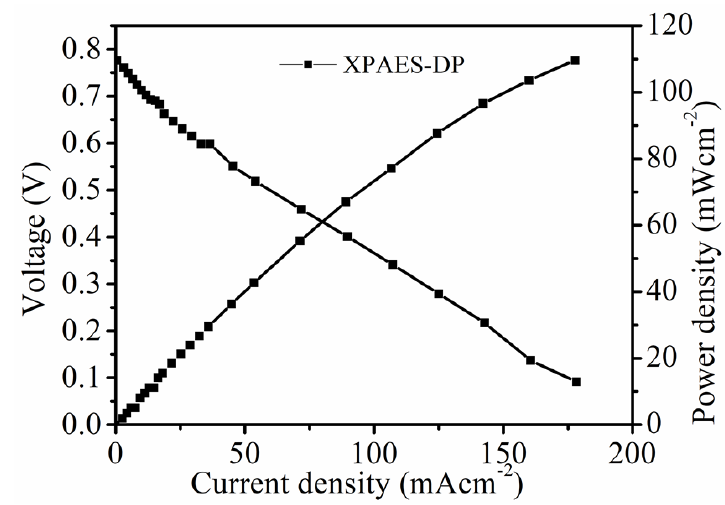
Figure 6. Polarization curve of XPAES-DP at 80 °C and 100 RH.